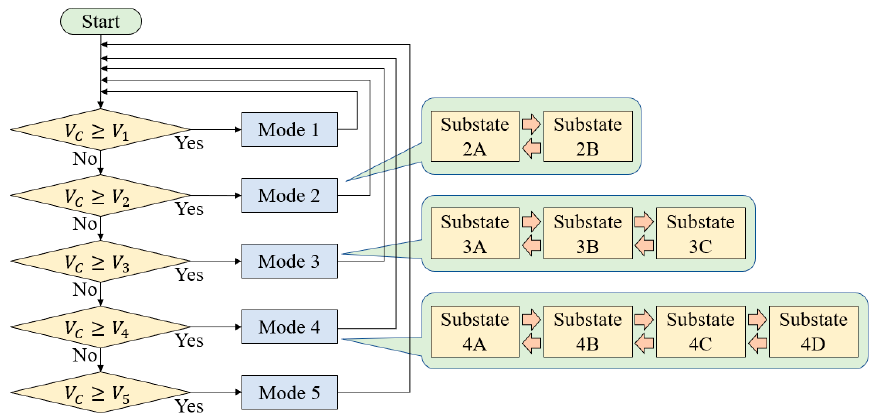
Figure 12. Flowchart of reconfiguration sequence.